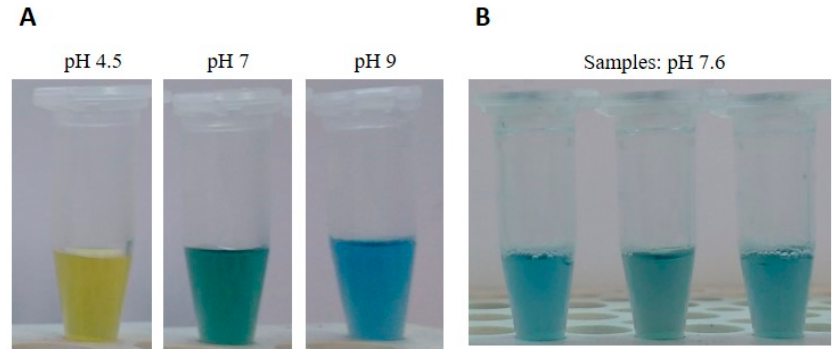
Figure 1. DNA extraction from blood samples. ( A ) Samples with different pH values, containing the bromothymol blue pH indicator (BTB). DNA samples appear yellow, green, or blue at acidic, neutral, or basic pH, respectively. ( B ) Color of solution at correct pH value (7.6).